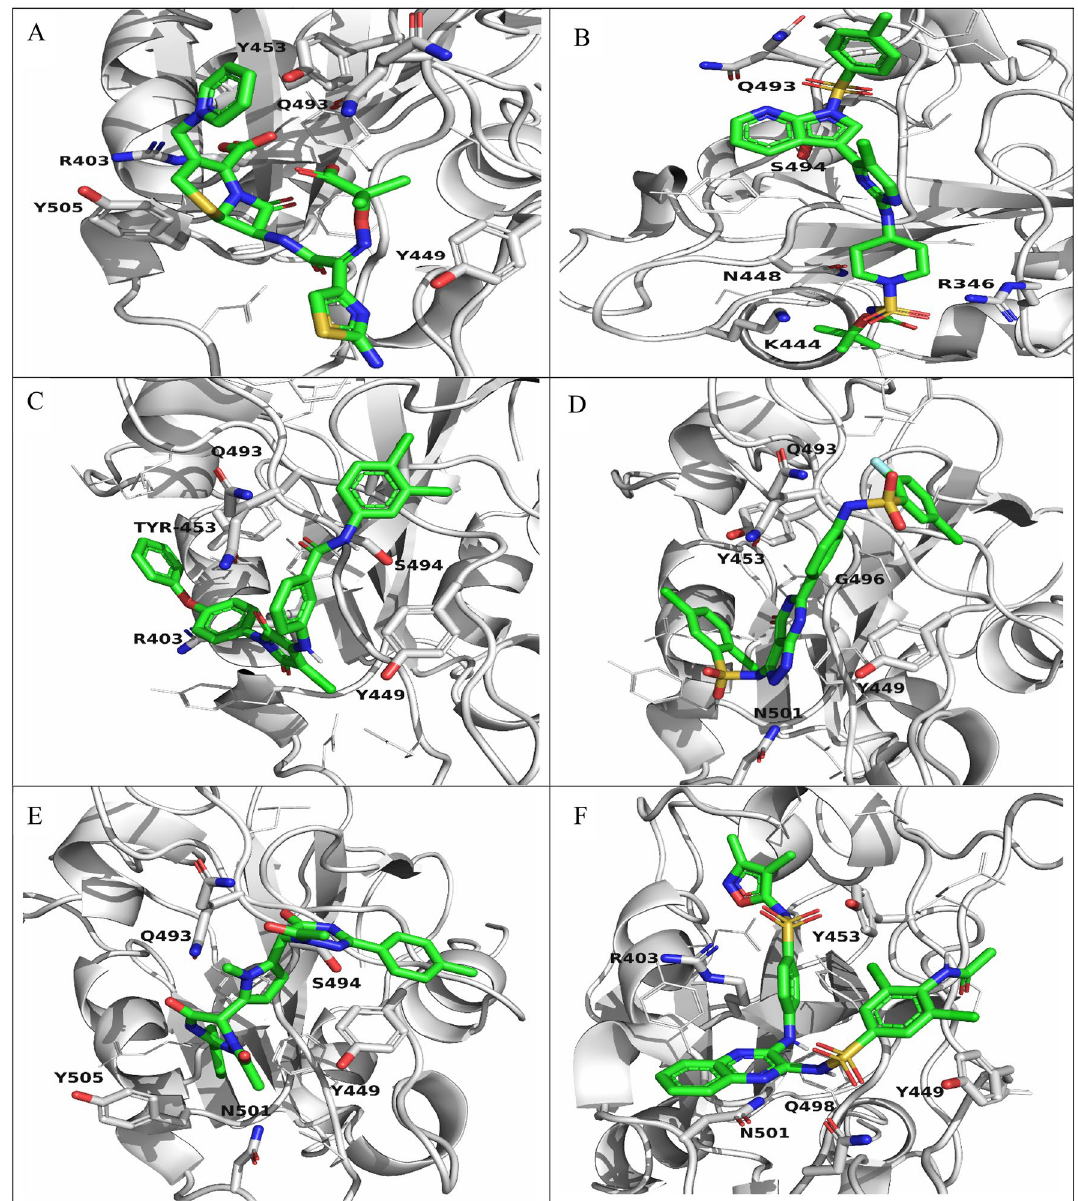
Figure 3. 3D visualization showing the redocking poses of the selected compounds and ceftazidime. The white cartoons represent the RBD, and interposes with white sticks represent the contacted residues. The ligands are represented as green sticks. ( A ) Ceftazidime. ( B ) CID:1. ( C ) CID:2. ( D ) CID:3. ( E ) CID:4. ( F )